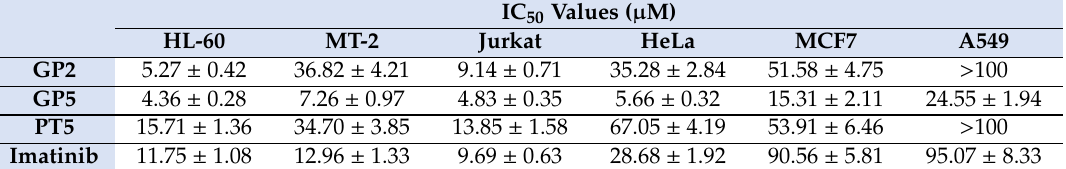
Table 2. The cytotoxicity of selected compounds against other cancer cell lines than K562.